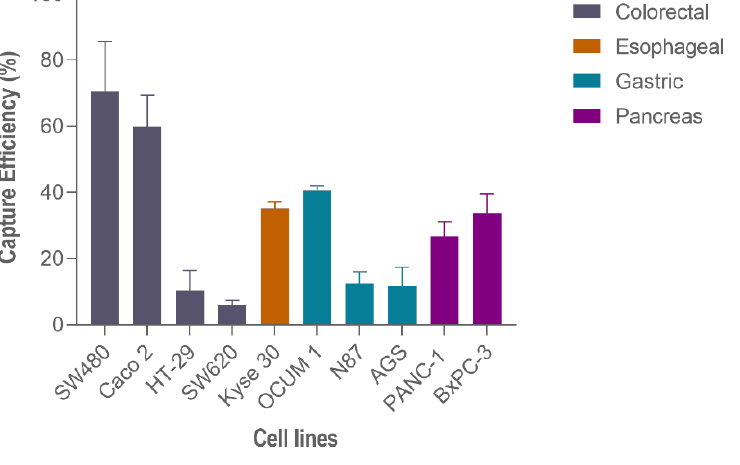
Figure 6. Capture efficiency of the RUBYchip™ using different gastrointestinal cancer cell lines.